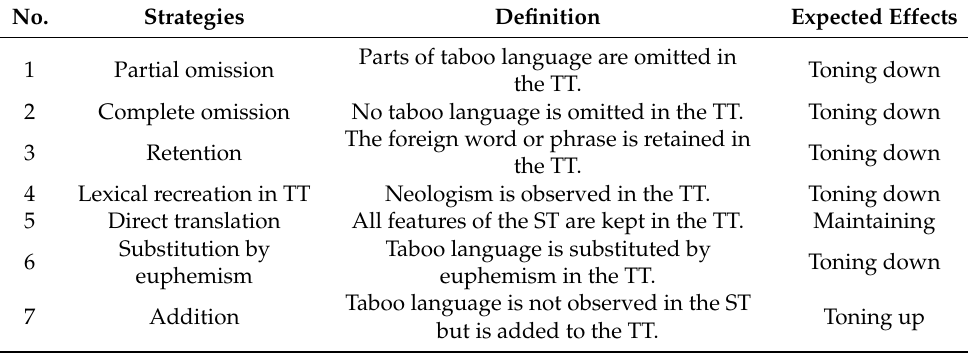
Table 1. Subtitling strategies, definition, and expected